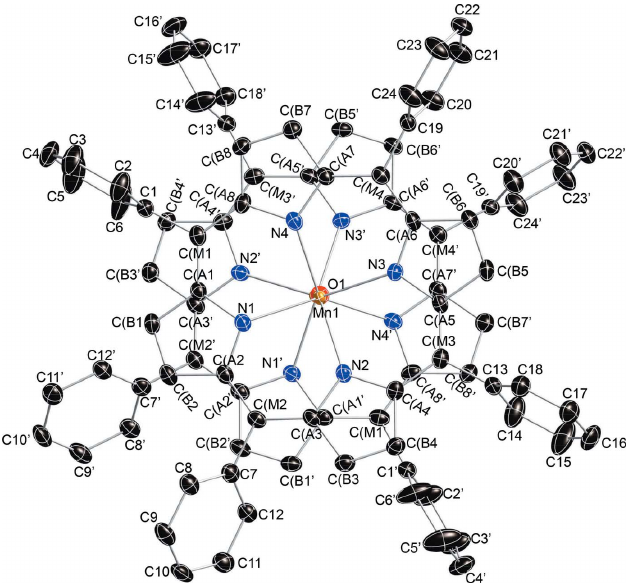
Figure 2 Top-view of the of the dinuclear complex of the title compound with displacement elliposids drawn at the 50% probability level. Hydrogen atoms are omitted for clarity. Primed atoms are generated by symmetry operation (cid:3) x + 1, (cid:3) y + 1, z .